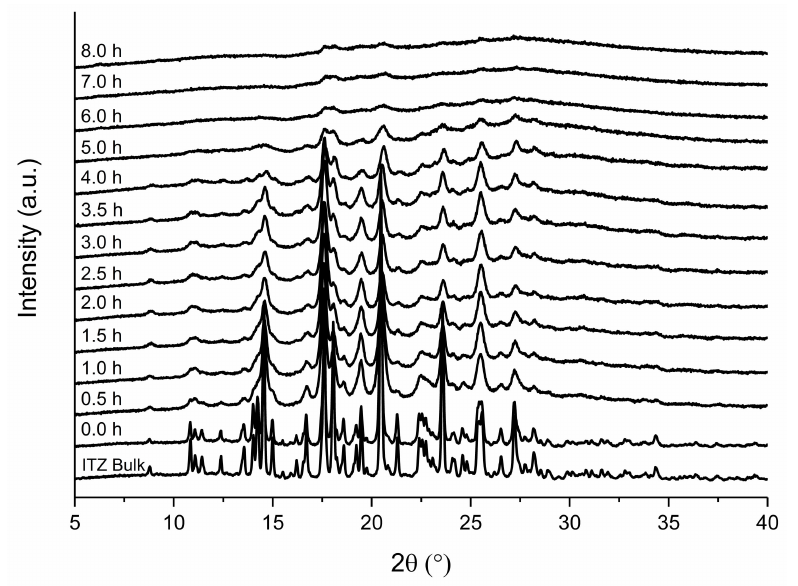
Figure 4. XRPD pattern of F2 in relation to grinding time. Milling was carried out at 4 ◦ C with 1500 rpm and milling beads sized 0.3–0.4 mm. Plots are shifted for a better illustration.